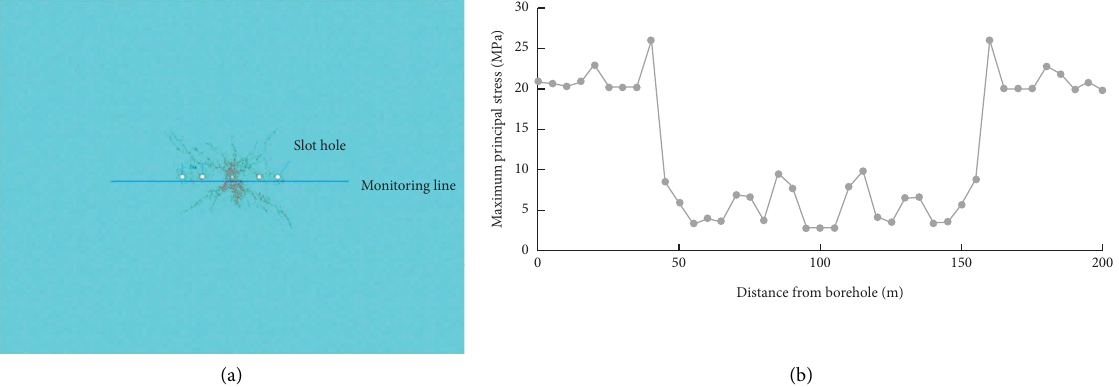
Figure 11: Fracture and stress distribution of seam after hydraulic fracturing. (a) Distribution of fractures. (b) Stress distribution